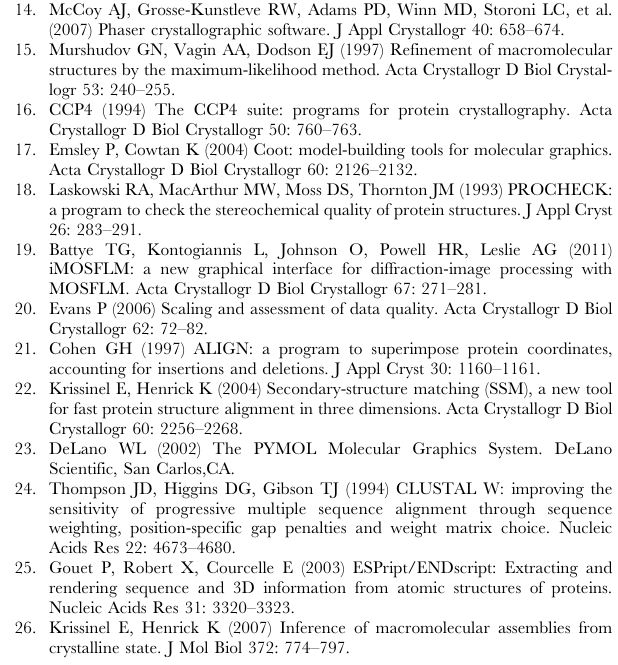
(green) of H234A mutant. C) and D) shows the 2Fo-Fc (0.8 s ) map of residues 230 and 234 respectively, in D230A/H234A. (TIF) Figure S3 Deviations of equivalent C a atoms of A and B chains after structural superposition plotted against H234A.